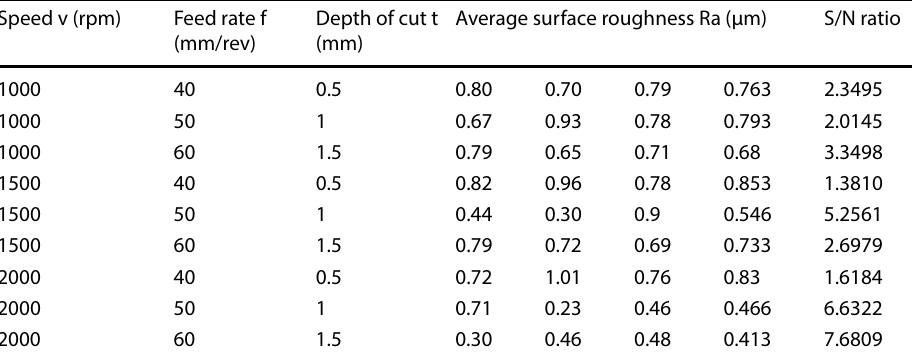
Table 2 S/N ratios for diferent process parameters (feed rate, cutting speed and depth of cut)